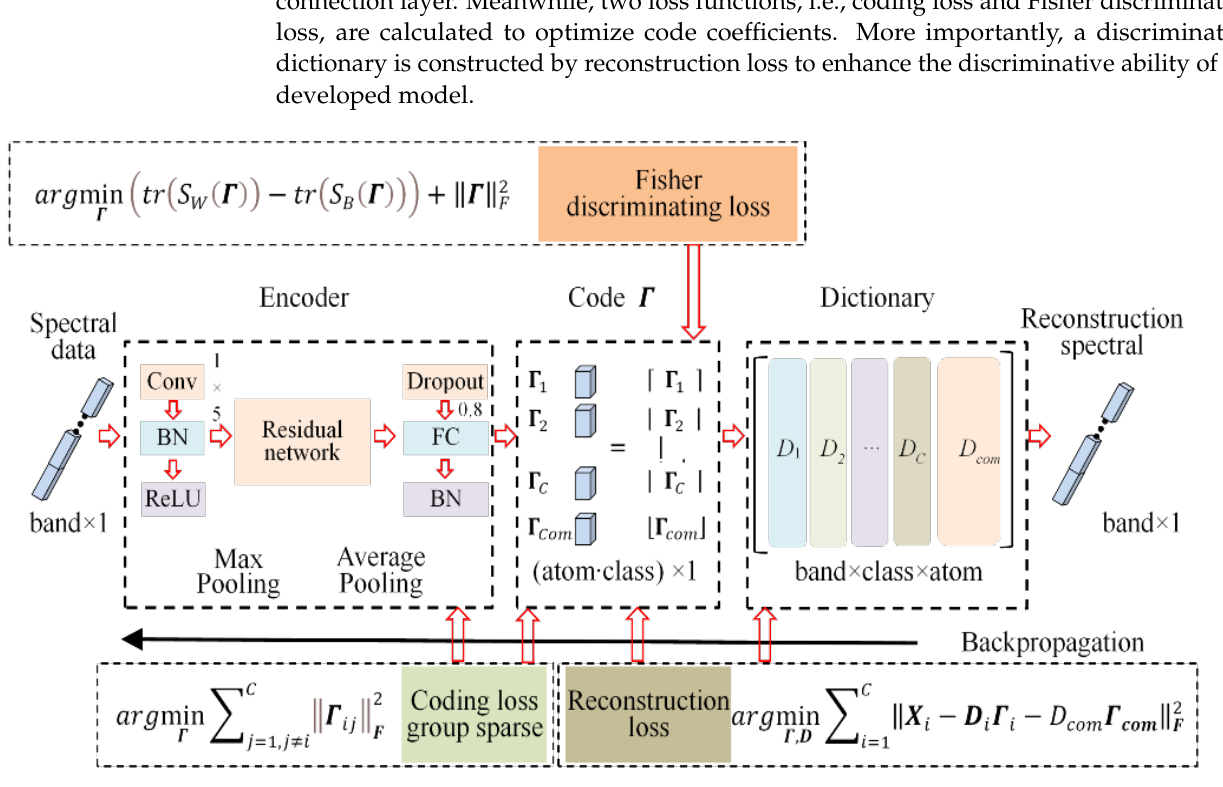
Figure 1. Workflow of the proposed feature extraction